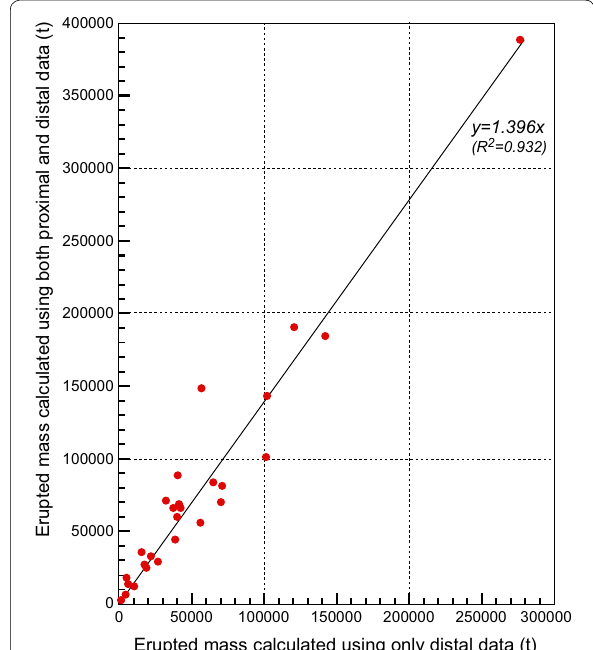
Fig. 8 Relation between erupted mass calculated using only distal data (> 1 km of the crater) and calculations using both proximal (crater rim) and distal data in the case of the 2014–2015 Nakadake eruption